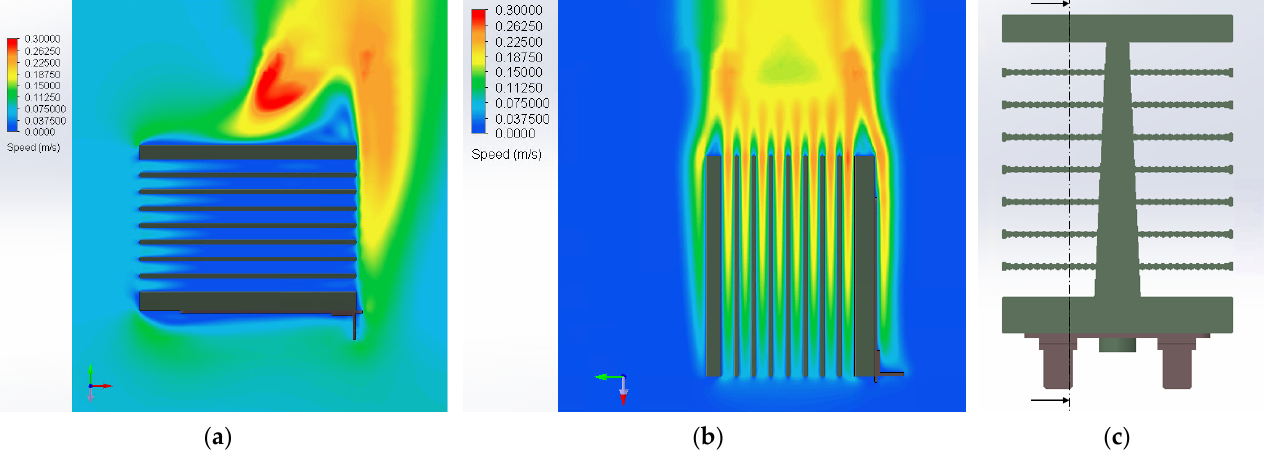
As expected, the air speed between the fins is higher in Setup 2. A section view plot